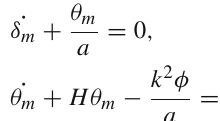
Fig. 1 The relative difference of the Hubble parameter using some typicalvaluesofthemodelparameters. Δ E becomespositive(negative) when b 1 > c 1 ( b 1 < c 1